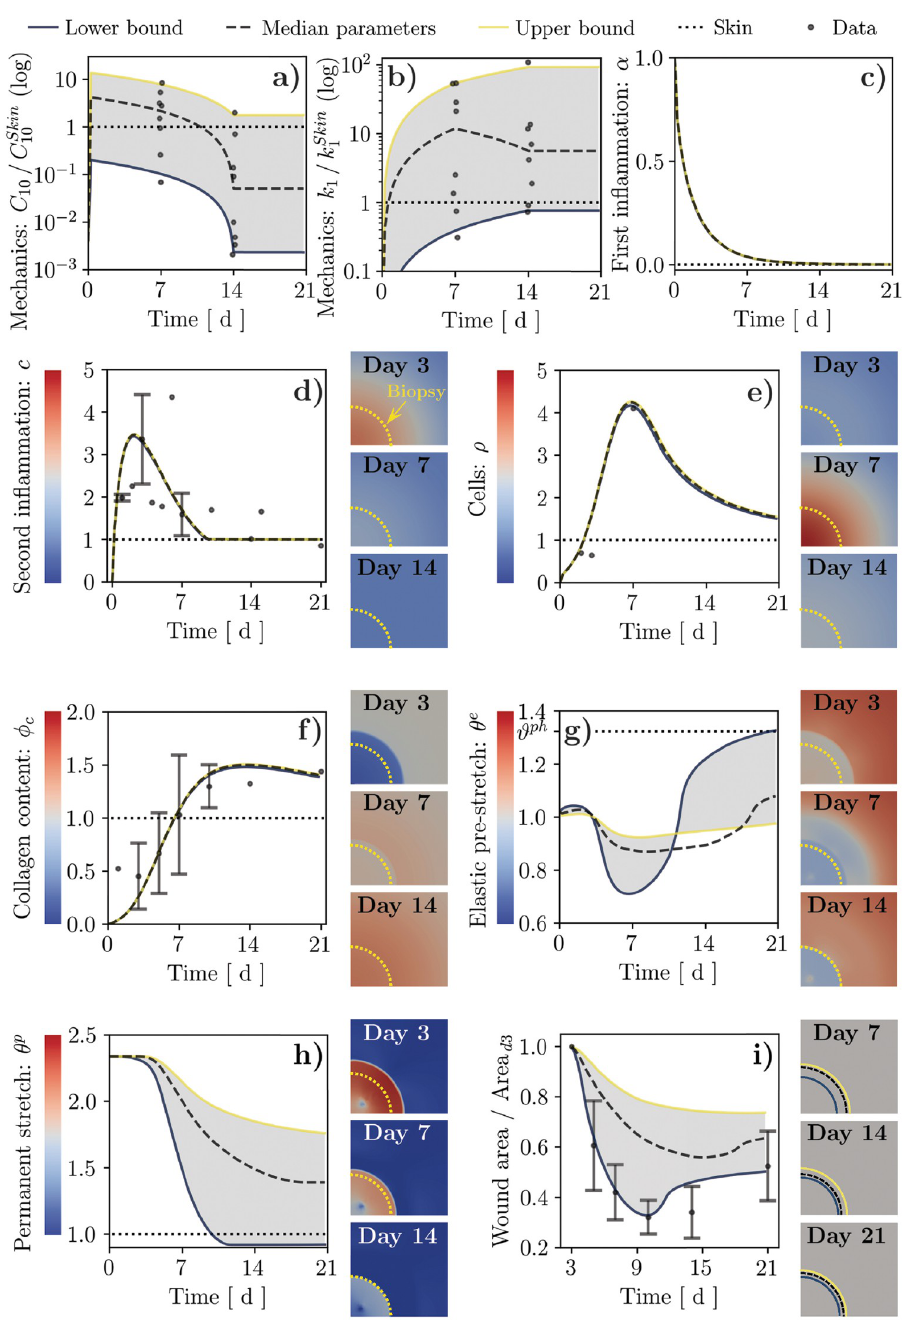
Fig 5. Results of wound healing simulations over a 21-day period using the wound mechanical parameters directly obtained from the Bayesian calibration procedure (median and 95% CI) and assuming linear variation between known or estimated values. ( a , b ) Hard-coded time evolution of the mechanical parameters C along with the corresponding values from Bayesian calibration (dots, cf. Fig 4). ( c ) Decay of the first inflammatory signal, α , in the wound. ( d – h )Time and spatial evolution of: second inflammatory signal, c ; cell population, ρ ; tissue collagen content, ϕ c ; tissue elastic stretch, θ e ; tissue plastic stretch, θ p . ( i ) Time evolution and illustration of wound area changes. Dots and error bars in ( d , e , f , i ):mean ± standard deviation of previously-published experimental data, cf. S1 Appendix and Ref.